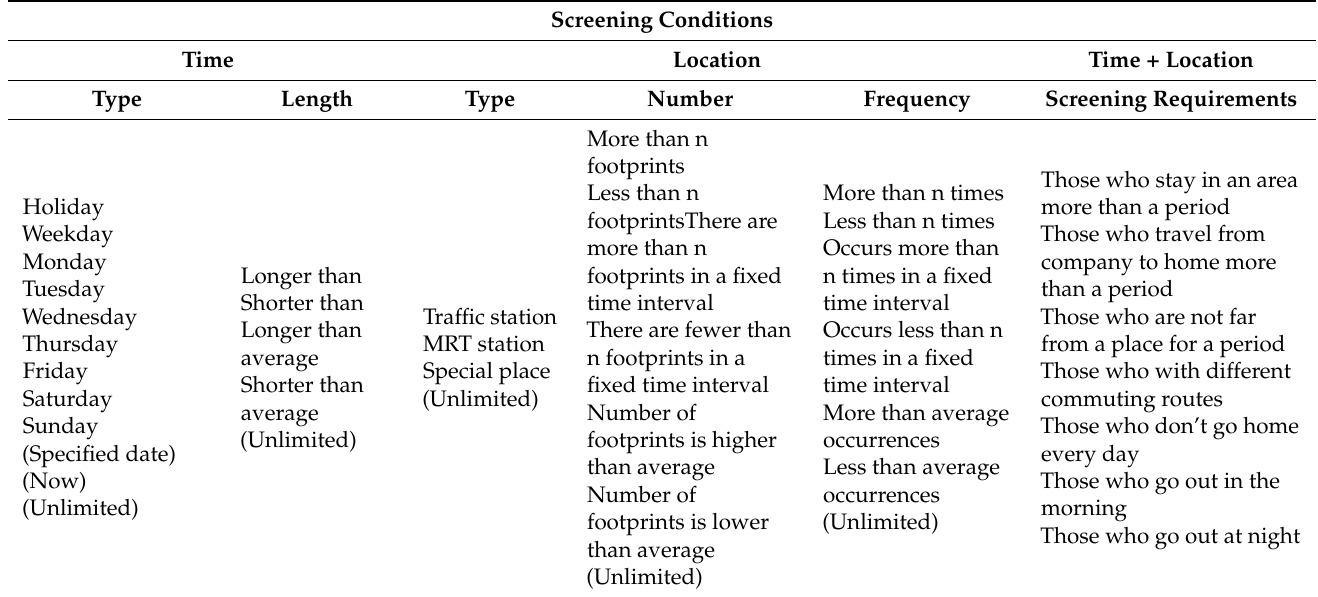
Table 1. Common time and location filtering conditions.